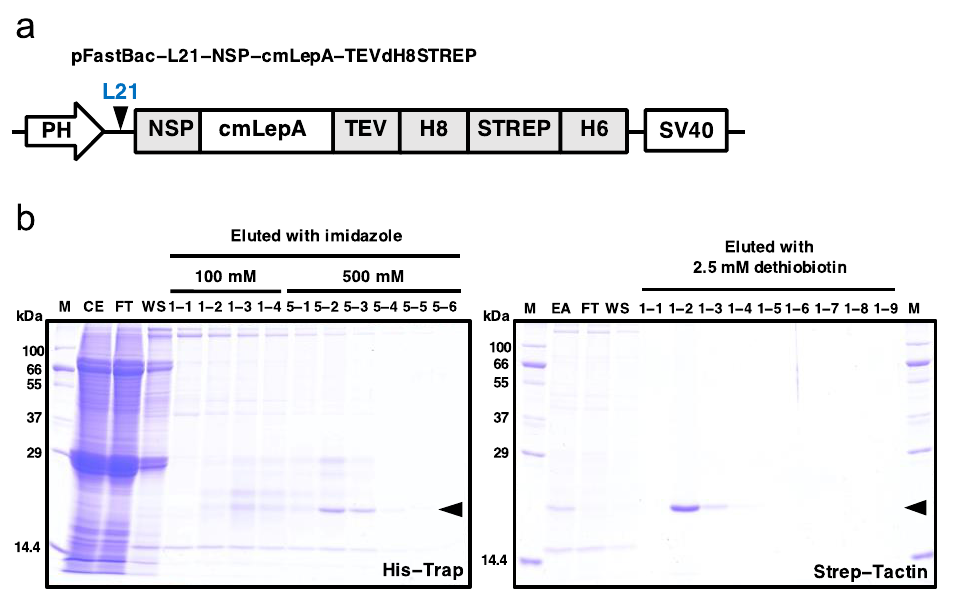
Figure 1. ( a ) Schematic representation of the construct to generate a recombinant baculovirus for leptin expression. The expression of leptin was under the control of the polyhedrin promoter (PH) and followed by an SV40 polyadenylation signal (SV40). L21: leader sequence for enhancing translation efficiency in baculovirus expression system; NSP: native signal peptide; cm-LepA: chub mackerel leptin-a, H8: 8x Histidine tag; STREP: Strep-tag; TEV: tobacco etch virus protease cleavage site. ( b ) Purification of leptin from silkworm pupae infected with the recombinant BmNPV via Nickel (His-Trap, left panel) and Strep-Tactin (right panel) affinity chromatography. The arrow indicates the expression of leptin in silkworm pupae. M: molecular weight markers; CE: crude extract; FT: flow-through; WS: wash fraction; EA: eluted fractions (lane 1-1 – 5-6, 10 μ L applied from 3 mL of each eluted fraction) from His-Trap was concentrated and diluted with PBS (-) and further purified by Strep-Tactin affinity chromatography. The leptin was eluted by 2.5 mM desthiobiotin on the Strep-Tactin (lanes 1-1 – 1-9, 10 μ L applied from 3 mL of each eluted fraction). Protein samples from each step were resolved by 12% SDS-PAGE and visualized using Coomassie Brilliant Blue (CBB) R-250 staining.